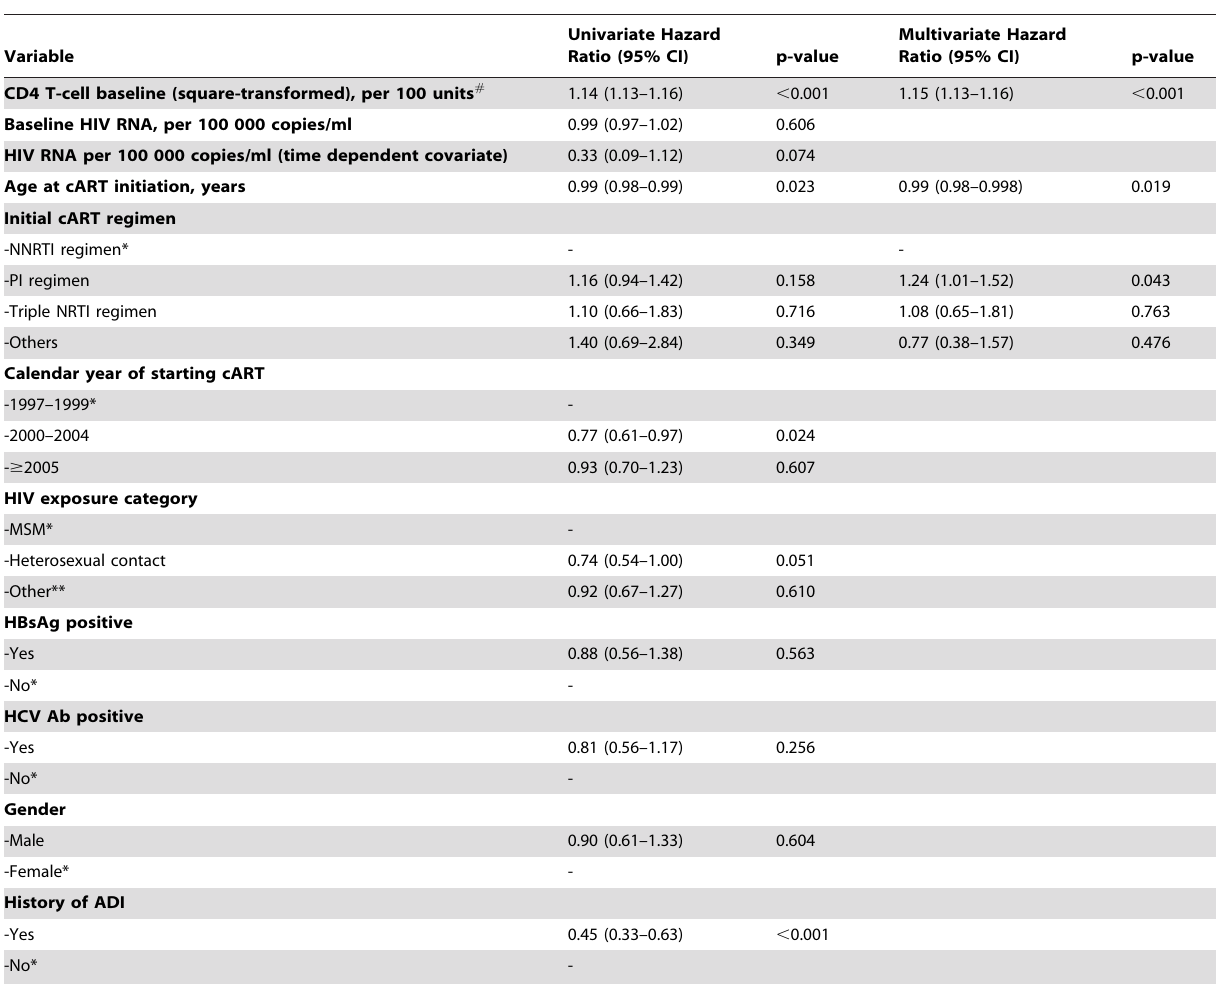
Table 2. Predictors of time taken to achieve CD4 T-cells . 500 cells/ m l (n